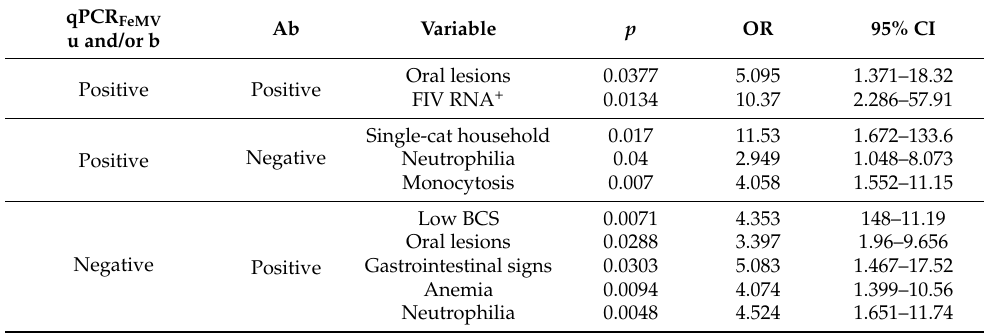
Table 10. Description of significant associations detected by Fisher’s exact test of the three infection patterns obtained with molecular (qPCR FeMV u and/or b) and serological (Ab) investigations related to FeMV with the investigated variables when compared to qPCR FeMV u and/or b and Ab negative pattern. Results are represented by p values, OR (odds ratio) and 95% CI (confidence intervals). qPCR FeMV Ab Variable u and/or b